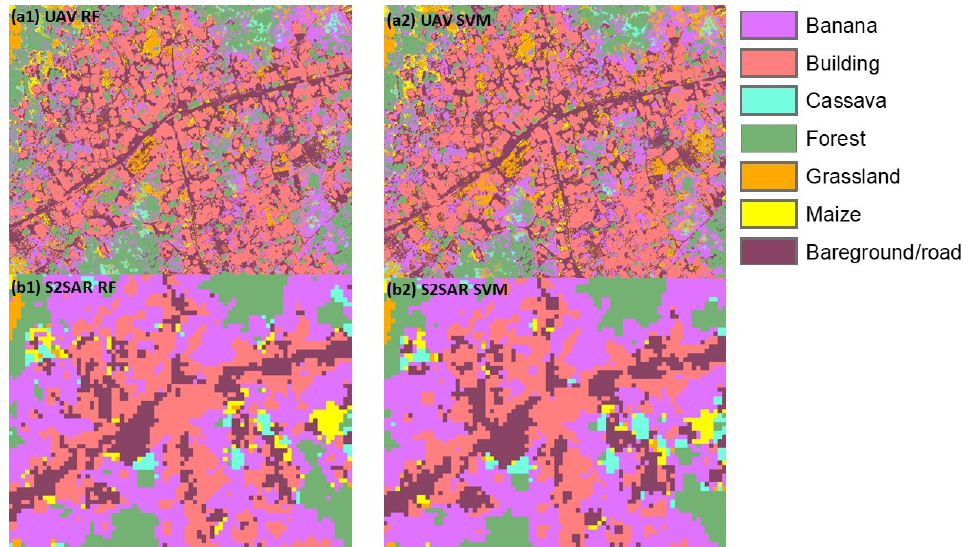
Figure 5. Comparison of the predictions of the Random Forest (RF) and Support Vector Machine (SVM) models for the UAV and Sentinel 2A data, fused with SAR data, in a high ‐ density banana production site (Olokuta, Nigeria).